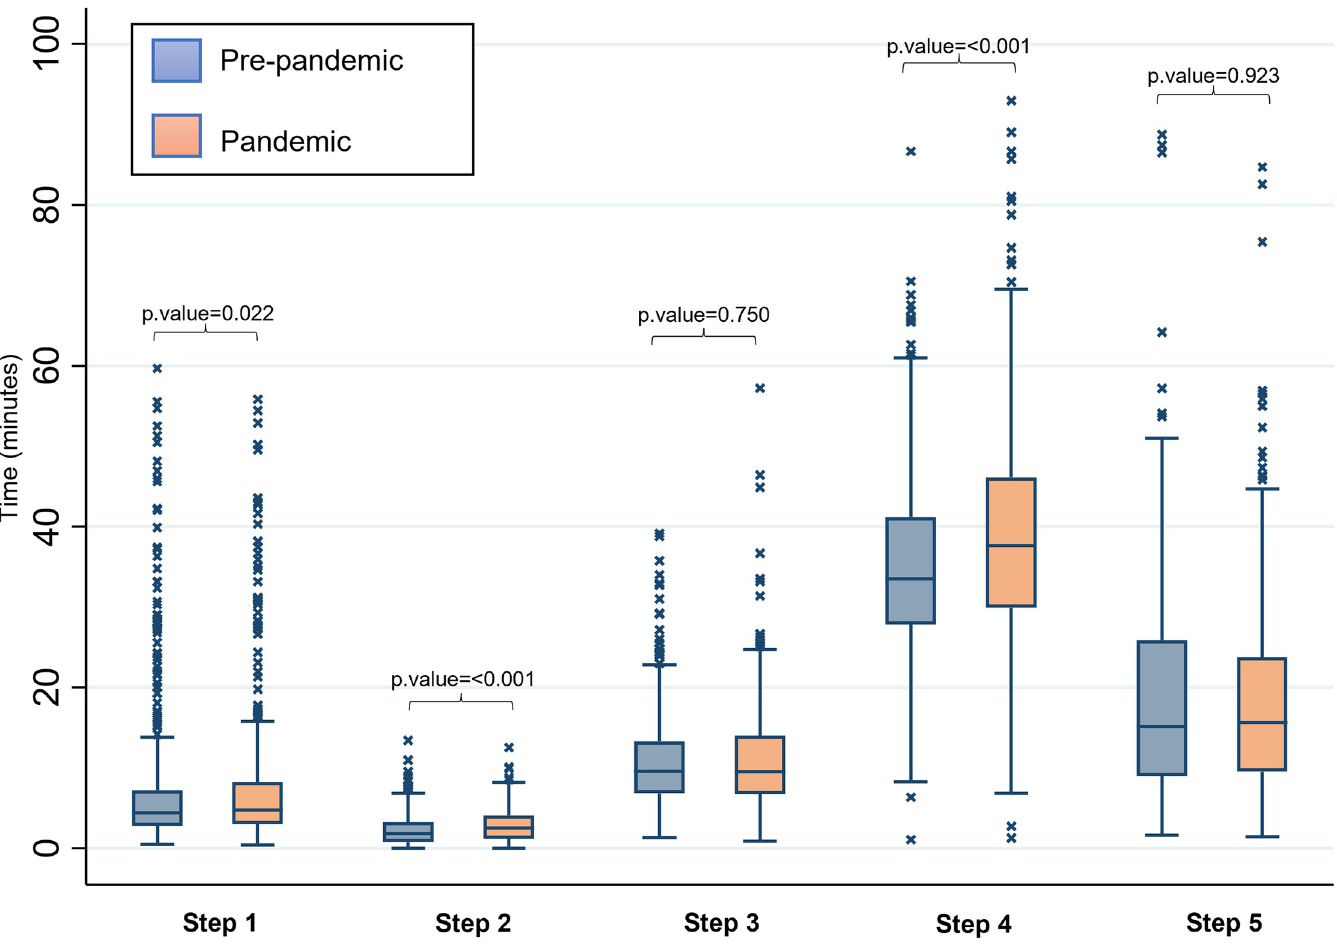
Fig 3. Box chart with prehospital times in each of the health care